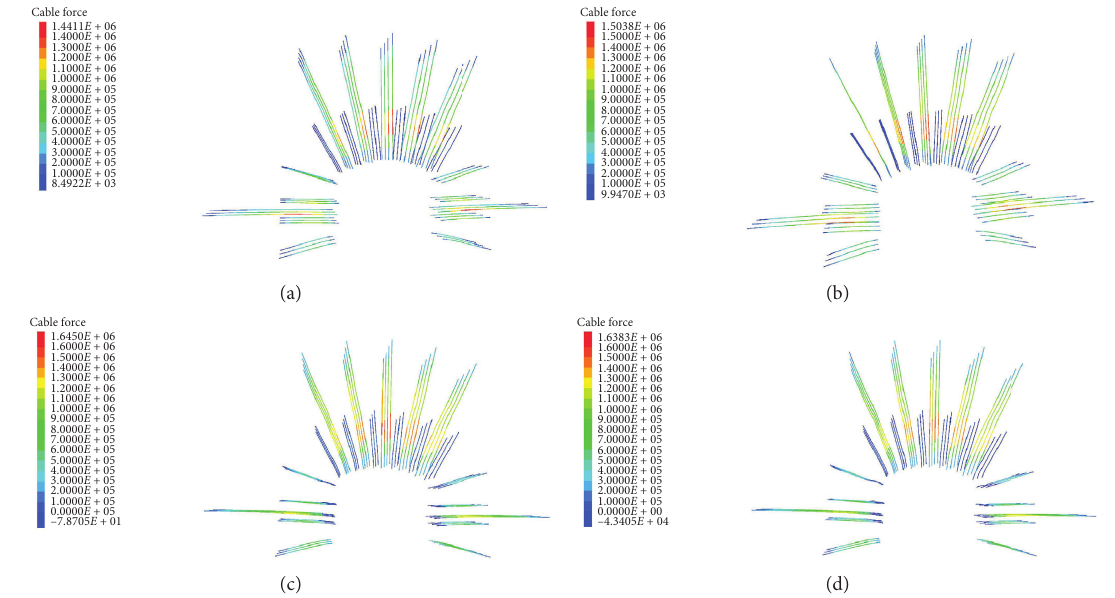
Figure 8: Stress condition of cable under different excavation distance. (a) Excavate 3 m. (b) Excavate 6 m. (c) Excavate 9m. (d) Excavate 12m.